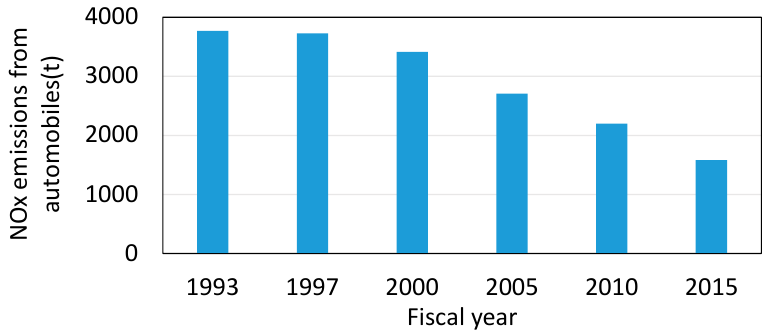
Figure 16. Trend in the emissions of NOx from motor vehicles. NOx emissions: estimates from the Kawasaki city government.